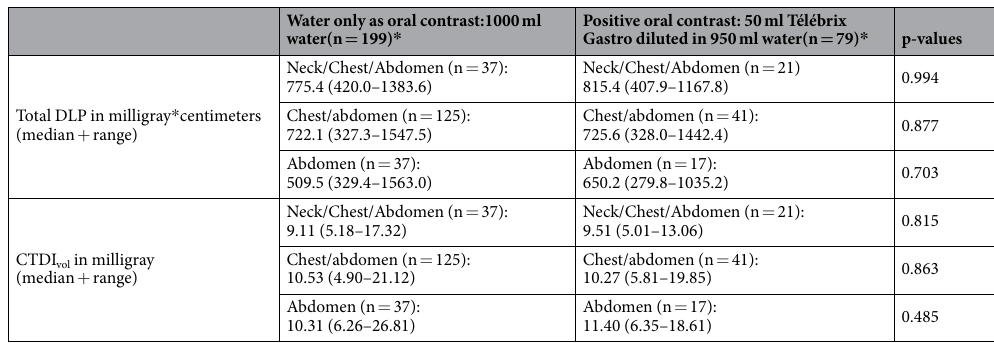
Table 2. Radiation exposure in patients per region scanned by 64 slice scanners. All data were non-normally distributed and therefore Mann-Whitney test was performed to compare the distribution between the two arms. * Data on 4 patients were not taken into account, as they did undergo additional phase